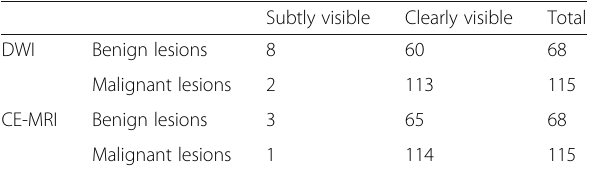
Table 2 Comparing lesion visibility in DWI and CE-MRI sequences Subtly visible Clearly